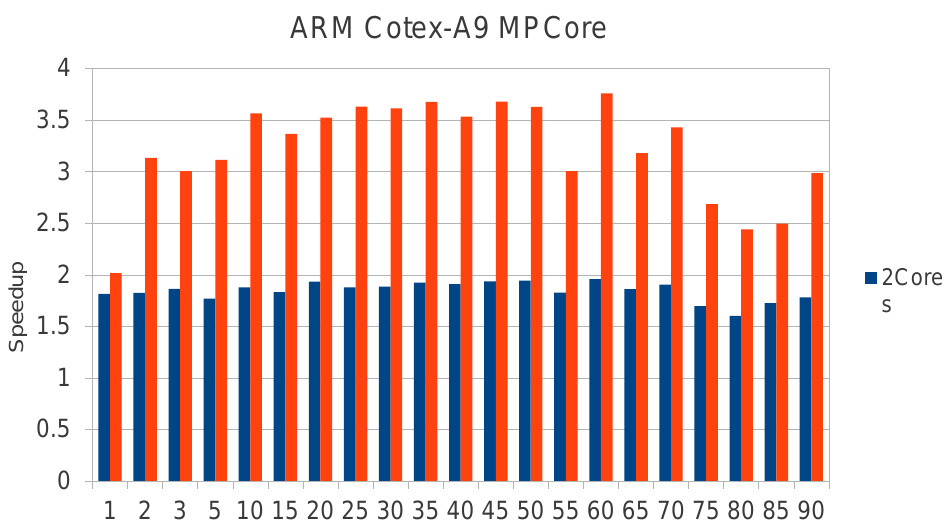
Figure 22. Speedup attained for 2 and 4 ARM Corex A9 processors.